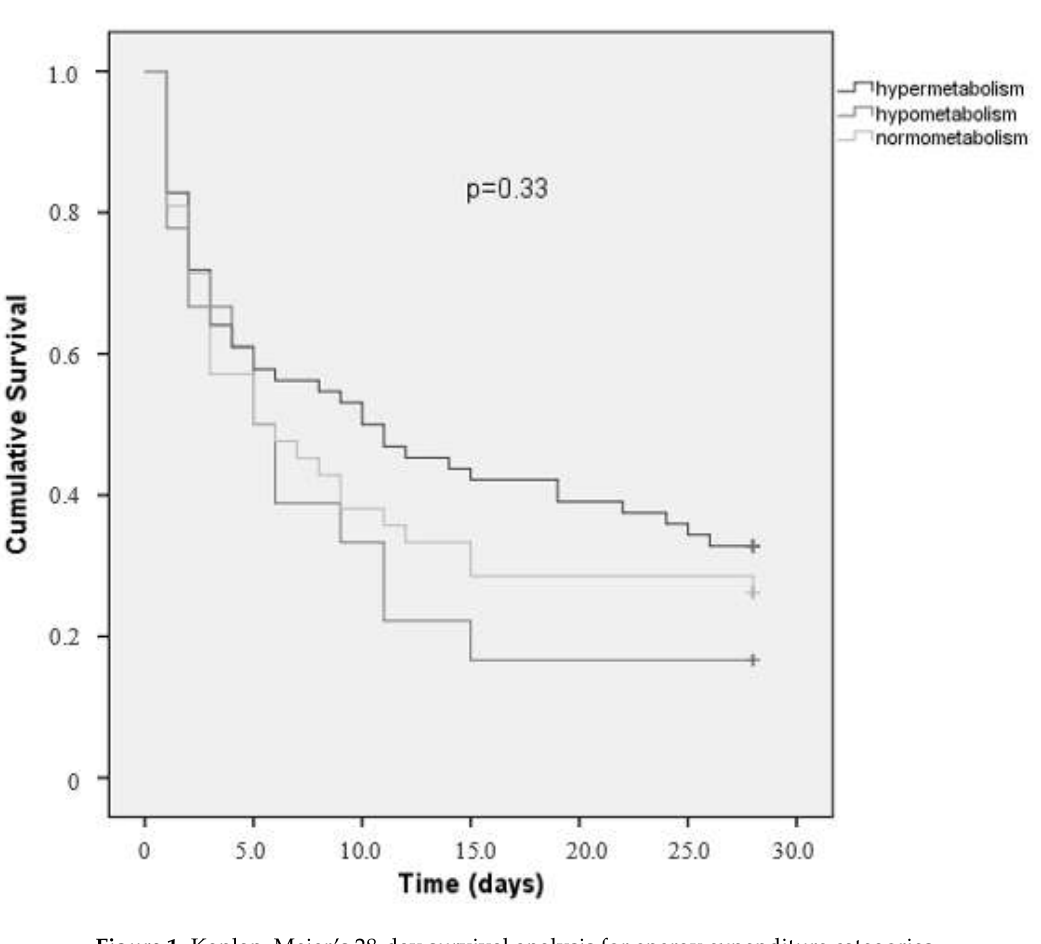
Figure 1. Kaplan–Meier’s 28-day survival analysis for energy expenditure categories.